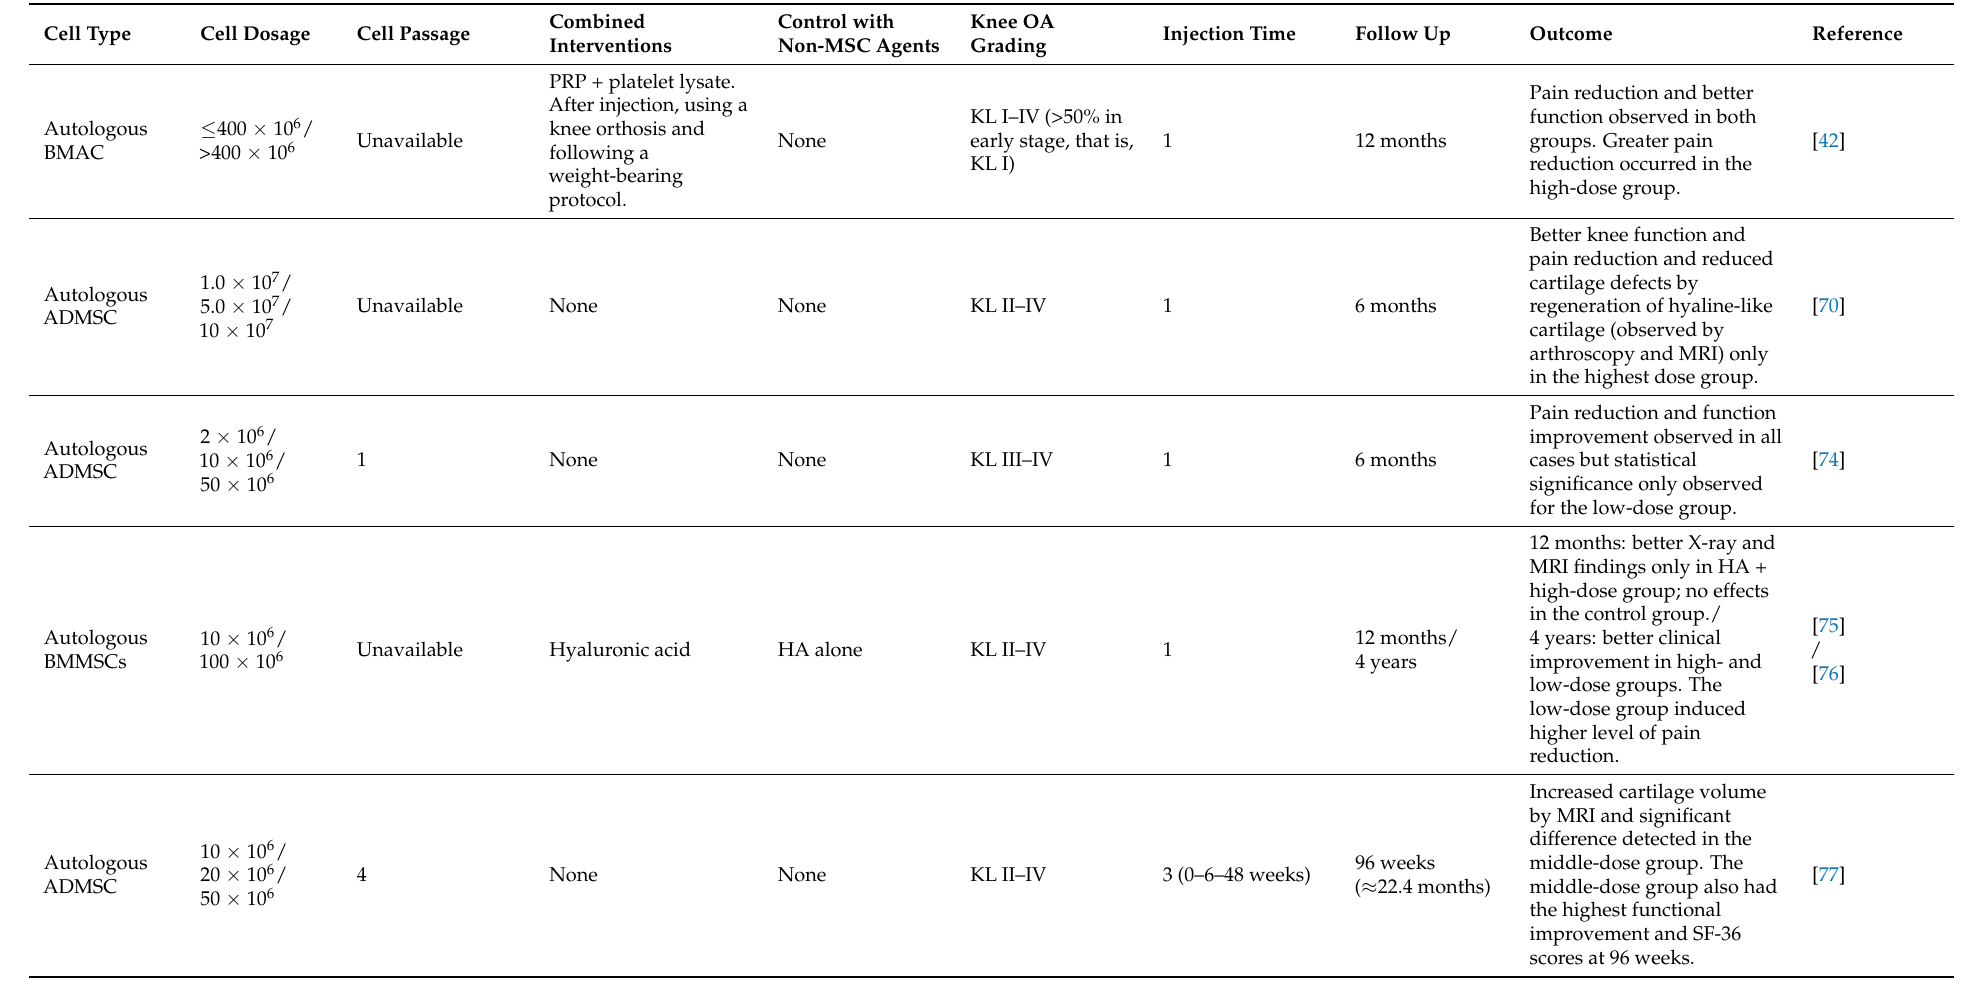
Table 6. Dose-comparison studies using autologous